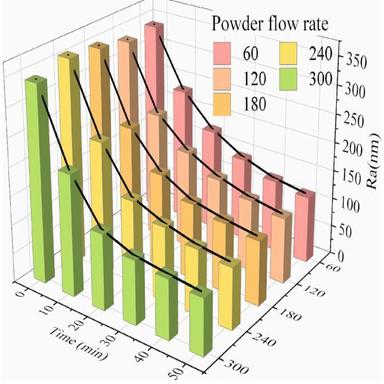
Graph of surface roughness with processing time.